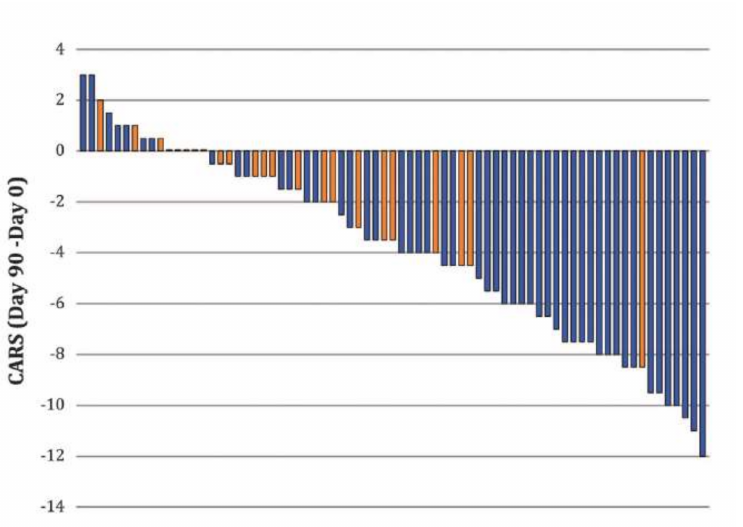
Figure 3. Bumetanide attenuates the severity of autism spectrum disorders (ASDs) in children 2–18 years old. A double-blind, randomized trial performed in several French centers using bumetanide treatment. Note that the CARS scale was reduced primarily and almost exclusively in children treated with bumetanide (blue columns) but not placebo with one exception (orange columns). Reducing CARS with 4 points or more is considered significant by EMA or FDA. From